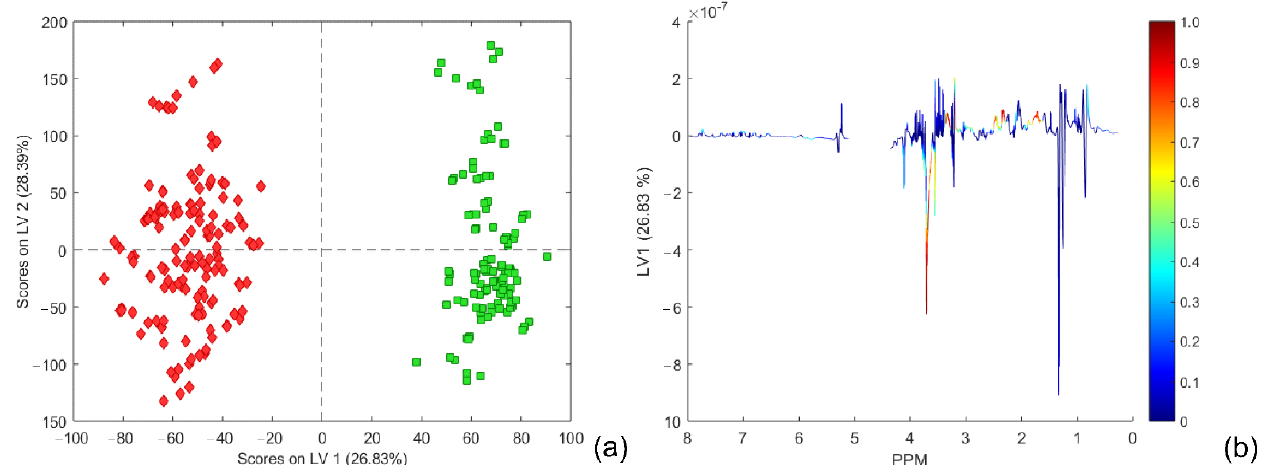
Figure 3. ( a ) Score plots of the first two LV components of the OPLS DA model using mean-centering and unit variance scaling (for a 4-component model, RMSEC = 0.0934 and RMSECV = 0.1304). The schizophrenia cohort is shown in red, and the control group in green. ( b ) Back-scale projection of loading vector LV 1 to coloring coded according to the absolute value of the particular loading weighted by correlation of the spectral data set and score matrix from the OPLS-DA model. Part of the loading plot belonging to the residual water signals was omitted from the plot.